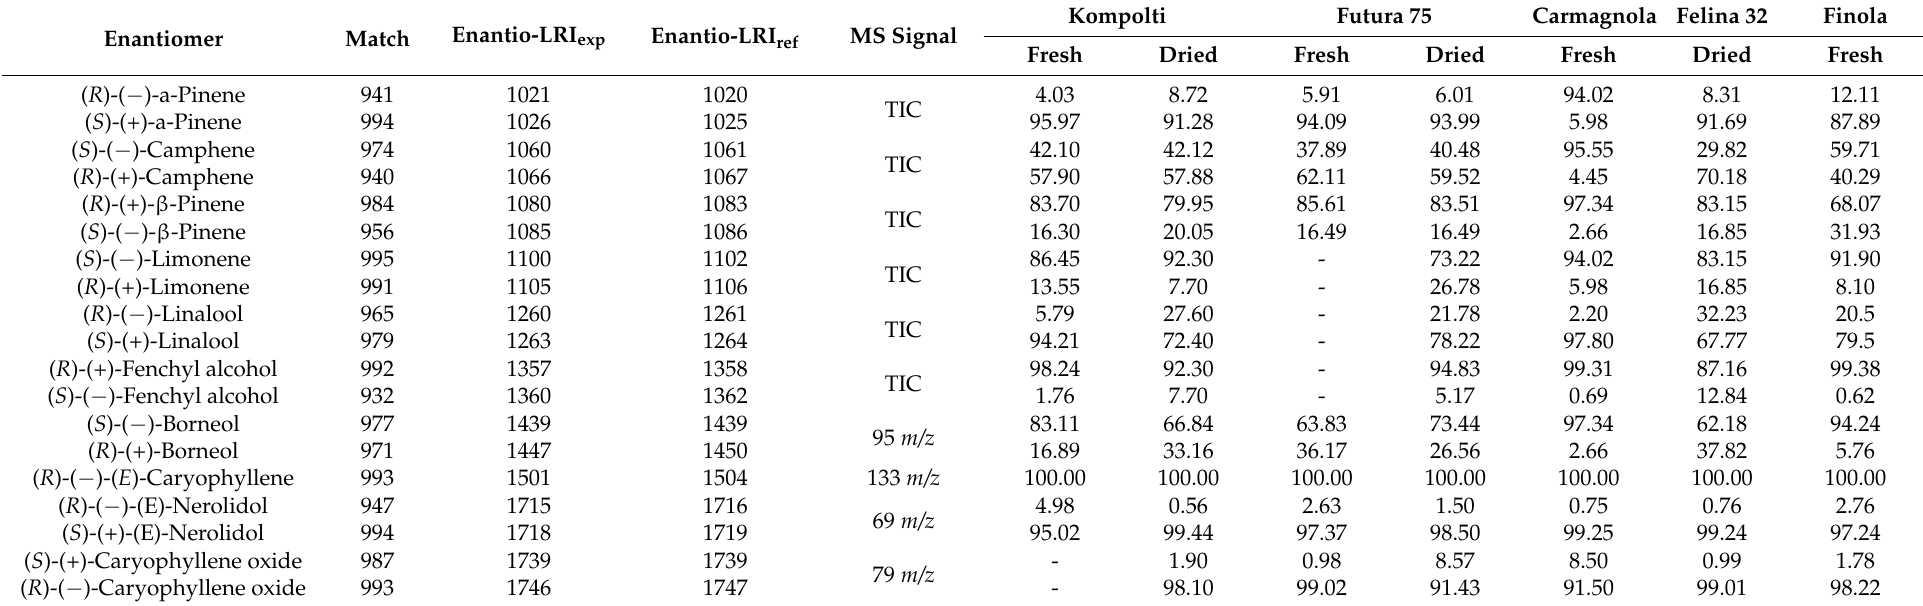
Table 4. Enantiomeric distribution of selected components in cannabis EOs from different cultivars. Abbreviations: match: database spectral similarity; enantio-LRI exp : chiral experimental LRI; enantio-LRI ref : chiral reference LRI; MS signal: mass signal